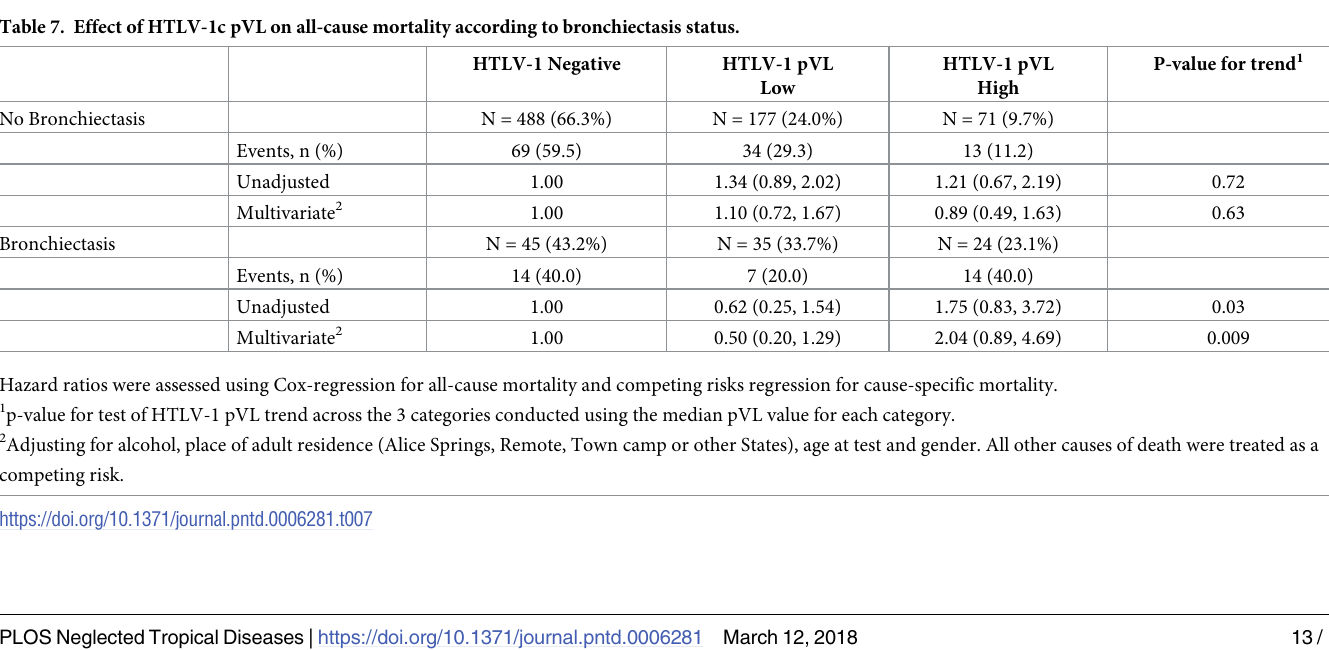
Table 7. Effect of HTLV-1c pVL on all-cause mortality according to bronchiectasis status.